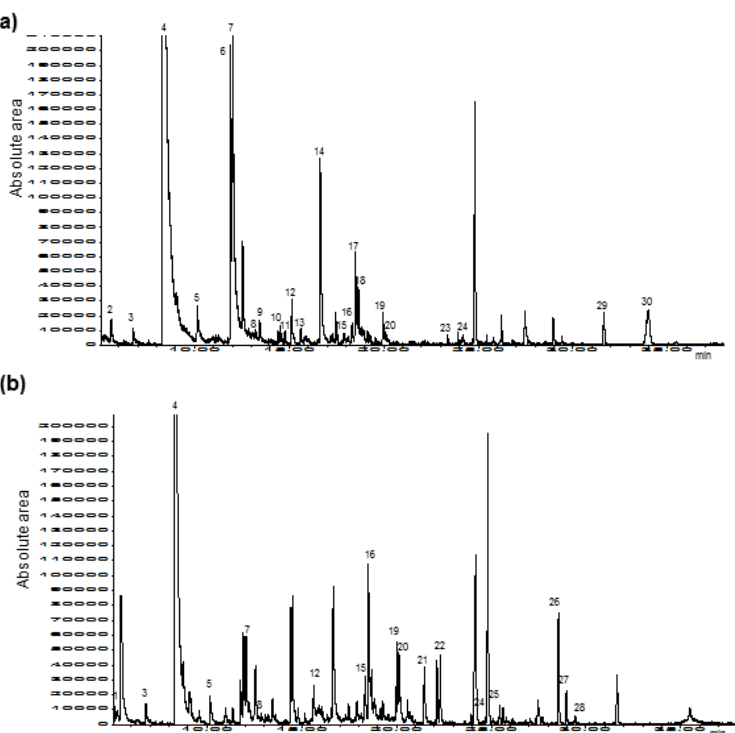
Figure 1. Chromatograms obtained from the SPME-GC-MS analysis of home-made ( a ) and commercial ( b ) strawberry jams under the best experimental conditions. The identification peaks were as follows: 1. 2-Methyl-1-penten-3-one, 2. Butyric acid, 3. Hexanal, 4. Furfural, 5. 2,5 dimethyl-4-methoxy-3-(2 H )-furanone (mesifurane), 6. 5-Methylfurfural, 7. Benzaldehyde, 8. 2-Acetylfuran, 9. Acetophenone, 10. Nonanal, 11. Phenylacetaldehyde, 12. 2-Methylbutyric acid, 13. 2-Heptanone, 14. Methyl 3-hydroxyhexanoate, 15. Benzyl alcohol, 16. Hexanoic acid, 17. 2-Hexenyl hexanoate, 18. Ethyl 3-hydroxyhexanoate, 19. (−)-α-Terpineol, 20. (+)-α-Terpineol, 21. 2,4-Hexadienoic acid, 22. Isobutyric acid, 23. Furan, 24. 5-Hydroxymethyl-2-furfural, 25. Benzyl acetate, 26. 2,4-Bis(1,1-dimethylethyl)- phenol (BHT), 27. γ-butyrolactone, 28. Methyl 3-hydroxyoctanoate, 29. Farnesol, 30. (−)-Furaneol.